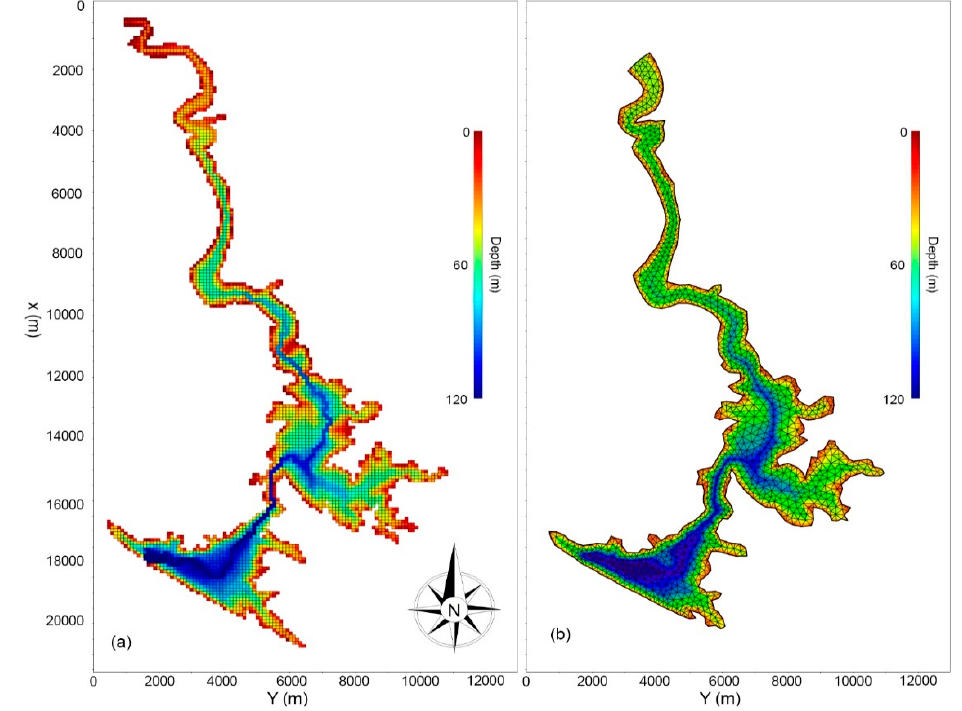
Figure 2. ( a ) AEM3D model grid; ( b ) MIKE3 model grid.